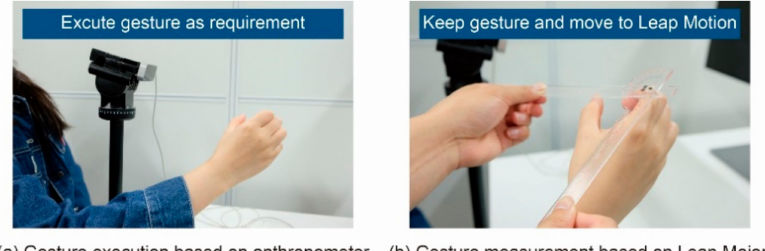
Figure 15. Schematic diagram of the experimental